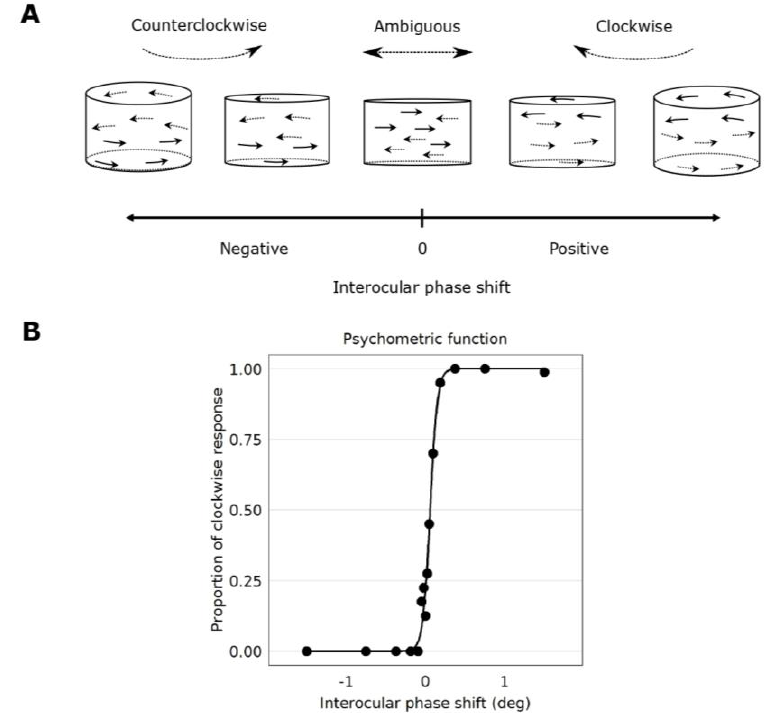
Figure 3. Psychometric function fits and the perceived rotation of the cylinder stimulus as a function of interocular phase shift. ( A ) When there is an interocular phase shift in the oscillation of the Gabor elements, the cylinder appears to rotate in depth. When the phase shift is negative, the rotation of the cylinder is seen counterclockwise. When the phase shift is positive, the rotation of the cylinder is seen clockwise. When the phase shift is 0 ◦ , the depth percept appears ambiguous, whereby Gabor elements are seen moving laterally in the plane of the screen. This figure has been adapted from Reynaud and Hess, 2017 [5]. ( B ) A psychometric function of the perceived rotation direction as a function of the interocular phase shift between the eyes from Subject 7. Datapoints were fitted by a logistic function. Each data point represents each interocular phase shift that was tested. The interocular phase shift for which the proportion seen clockwise is 50% marks the point of subjective equality (PSE). It is where the rotation of the cylinder is ambiguously clockwise or counterclockwise to the observer.